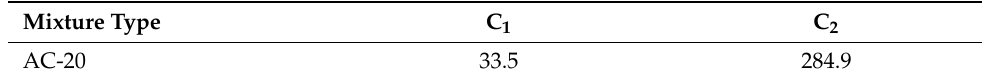
Table 5. WLF equation constants of asphalt materials [49].